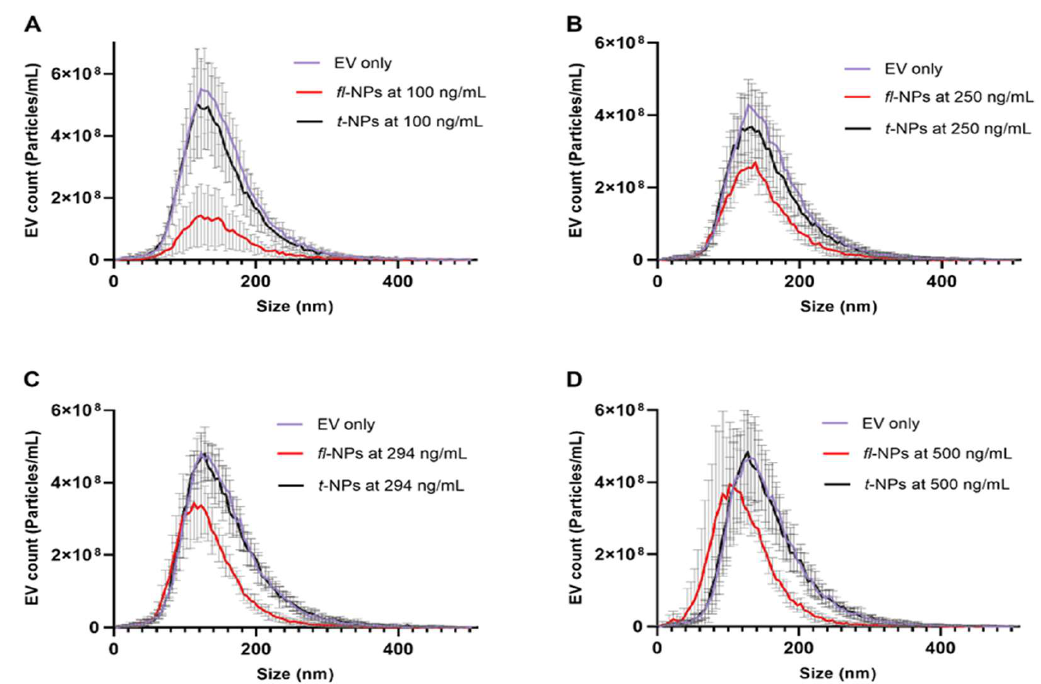
Figure 4. Effect of CMG concentration on the size profile distribution of fluorescent and total NPs of EVs measured using Zetaview ® - NTA. ( A – D ) Size profile distribution for fl- NPs originating from JAr cells measured at a minimum brightness threshold value of 25 with different CMG concentrations of 100, 250, 294 and 500 ng/mL respectively. EVs only as a control, fl and t -NPs of EVs diluted in 1× PBS and measured in fluorescent and scatter modes of NTA (mean ± SD, n = 9).